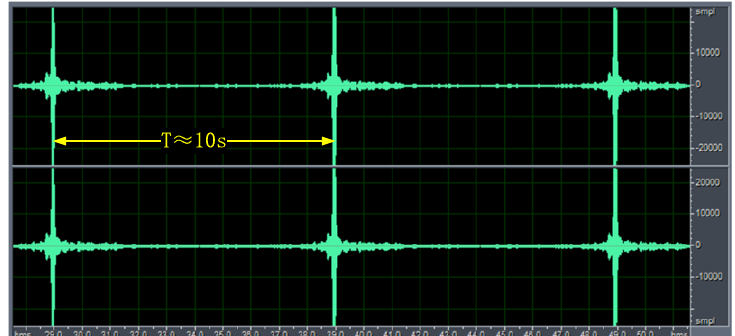
Figure 10. The collected IQ data of the reference channel with multiple antenna rotation periods.